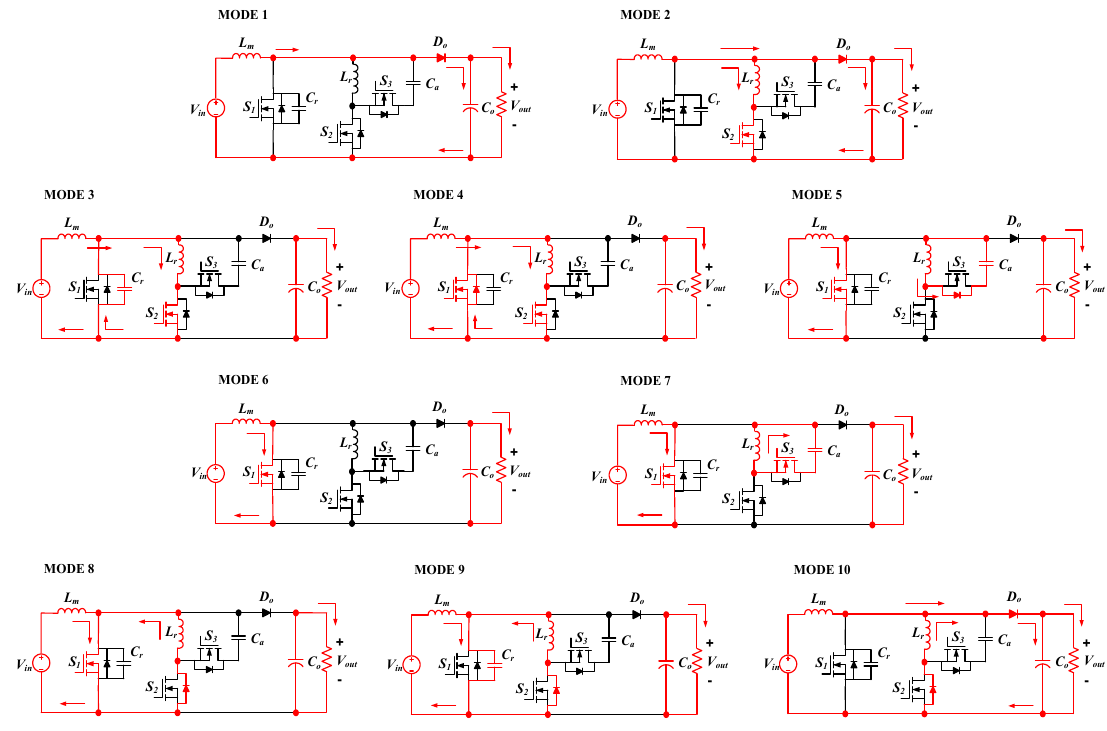
Figure 3. Operation mode of the proposed ZVT resonant boost converter.